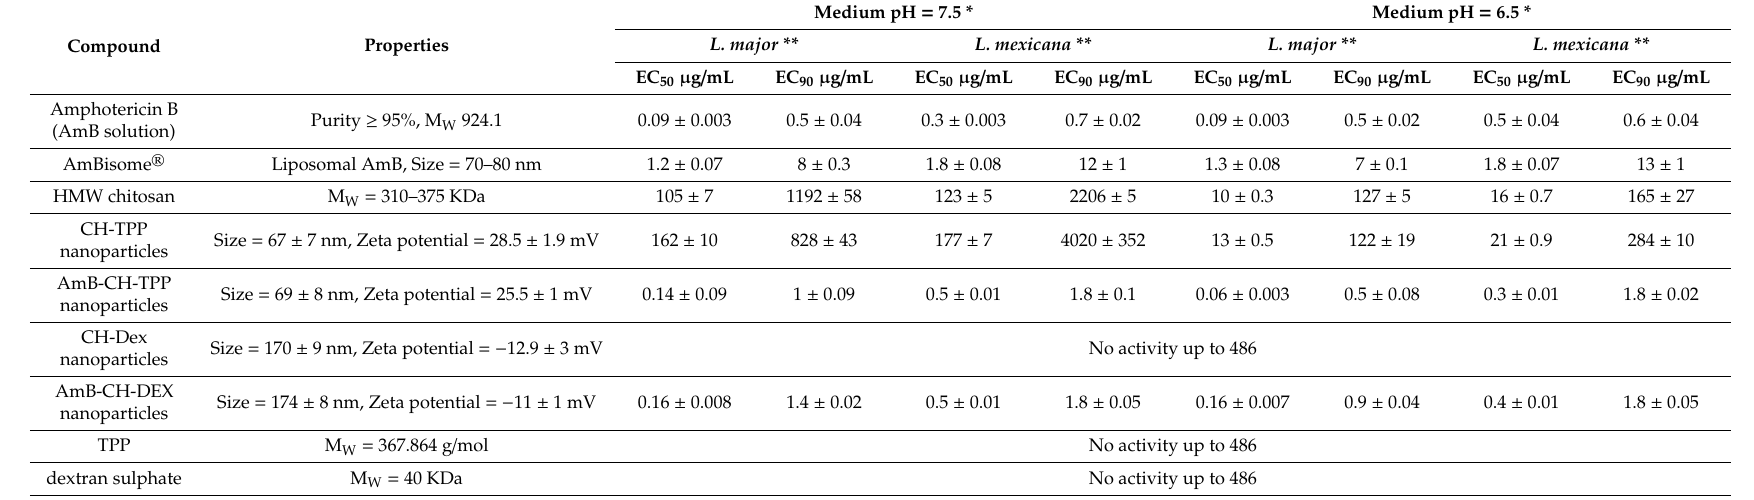
Table 2. In vitro activity of chitosan formulations against intracellular Leishmania amastigotes at two pH